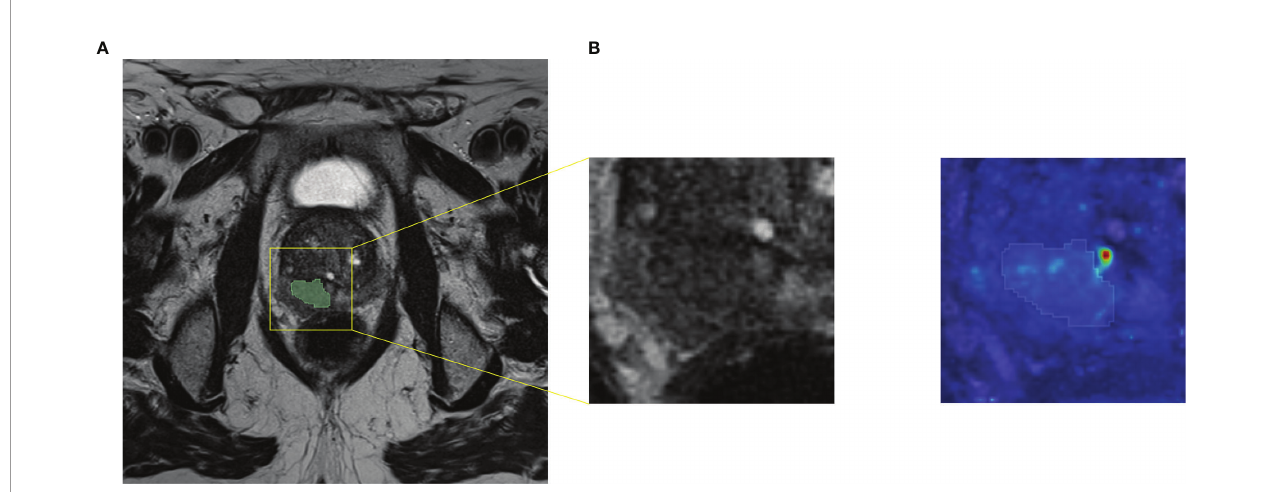
FIGURE 6 | Axial T2w MR image of a PCa lesion with PI-RADS=5 and GS=4+5. (A) Original image together with its cropped version of size 64x64. We fed AG DL frameworks with the cropped images, i.e. the C-DS images. (B) Attention map obtained from the best performing AG DL framework fed with T2w C-DS images, superimposed to the original cropped version of the T2w image and its